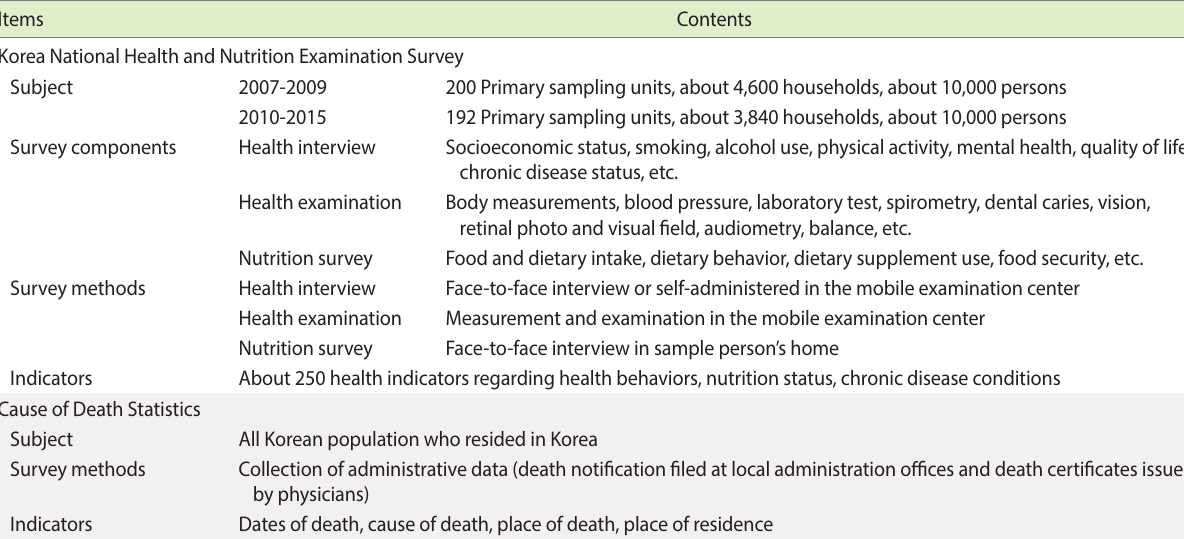
Table 1. Summary of the Korea National Health and Nutrition Examination Survey and the Cause of Death Statistics